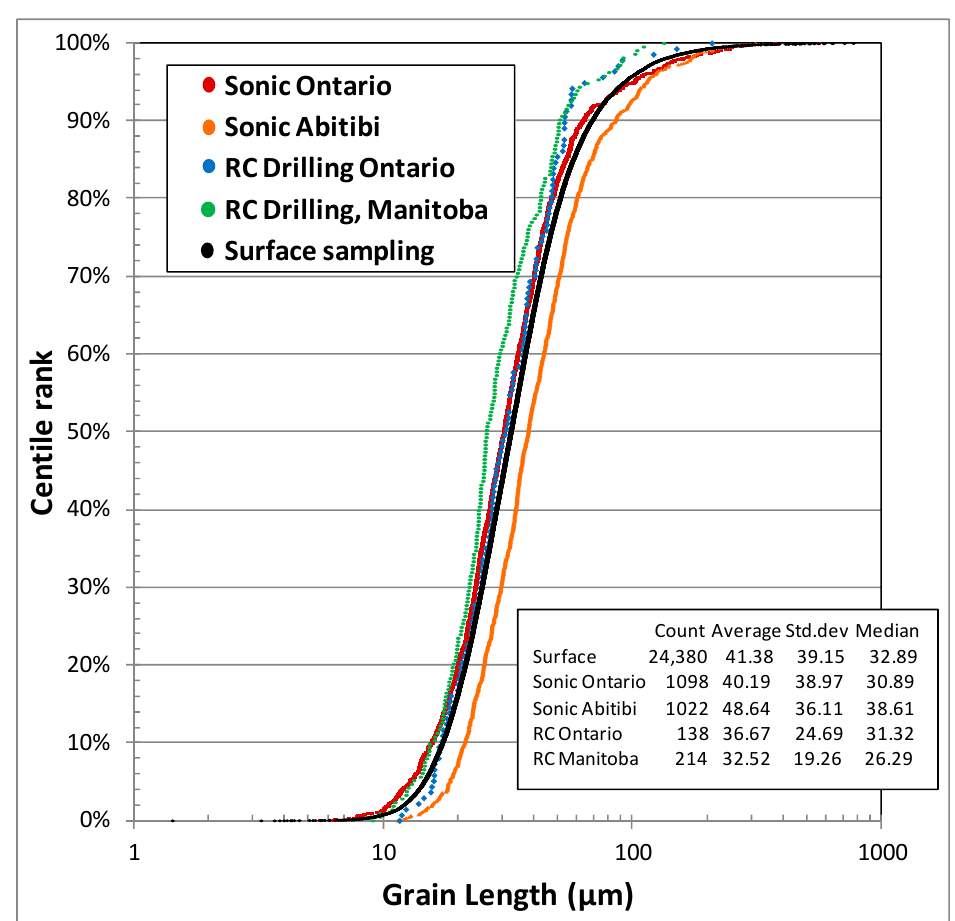
Figure 5. Gold grain size cumulative distribution plots according to sampling procedures. No significant difference is noted between samples collected from surface with a hand shovel, unperturbed core samples collected by Sonic drilling, and slurry generated by reverse circulation (RC) drillings. Material collected from RC drilling, although affected by severe mud elutriation, do not experience significant small gold grain losses at the scale of what can be recovered by the fluidized bed.